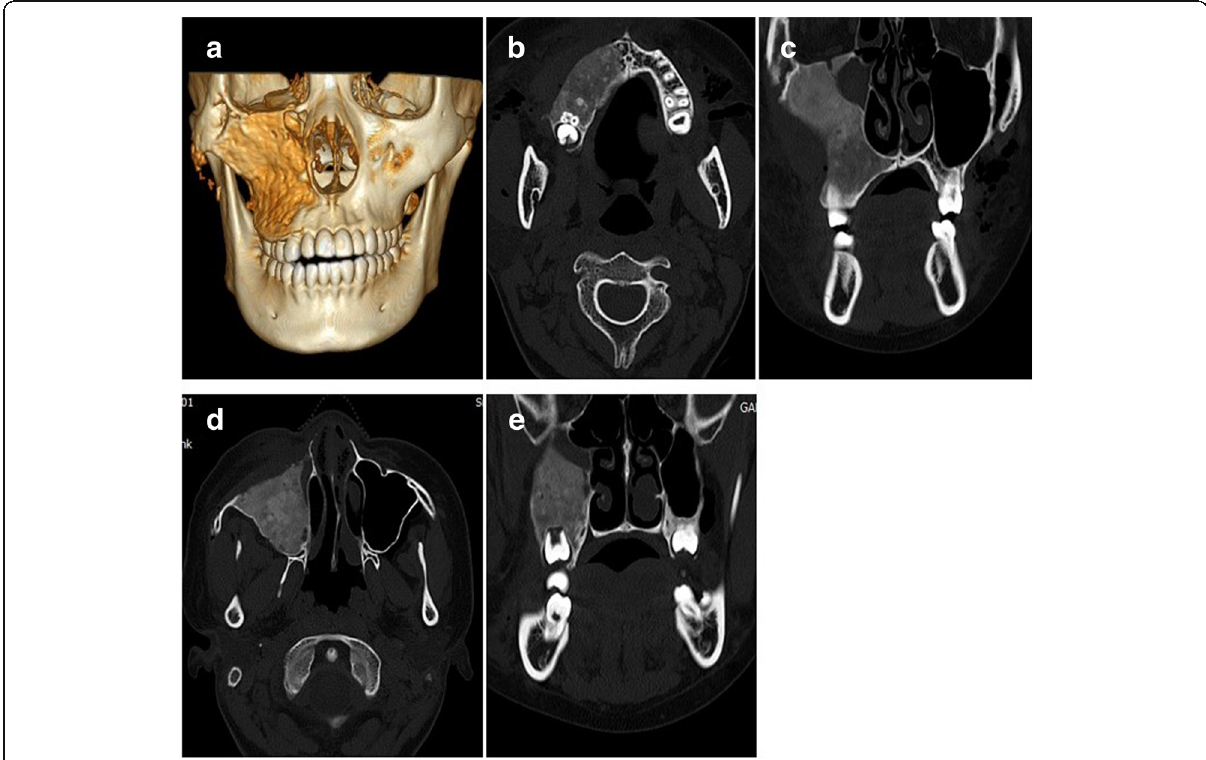
Fig. 6 Postoperative radiographic images. a Postoperative 3D CT image showed relatively symmetrical skeletal contours and cortical bone formation on surgical site. b , d Four-month postoperative axial CT showed the restoration of the anterior protrusion of the maxilla. c , e Four- month postoperative coronal CT showed the improved contour of the right